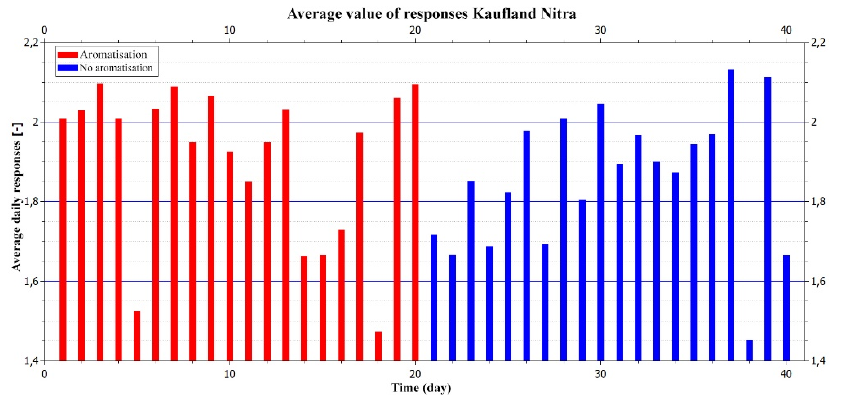
Figure 11. Comparison of evaluation of the atmosphere of the department during the experiment period with and without